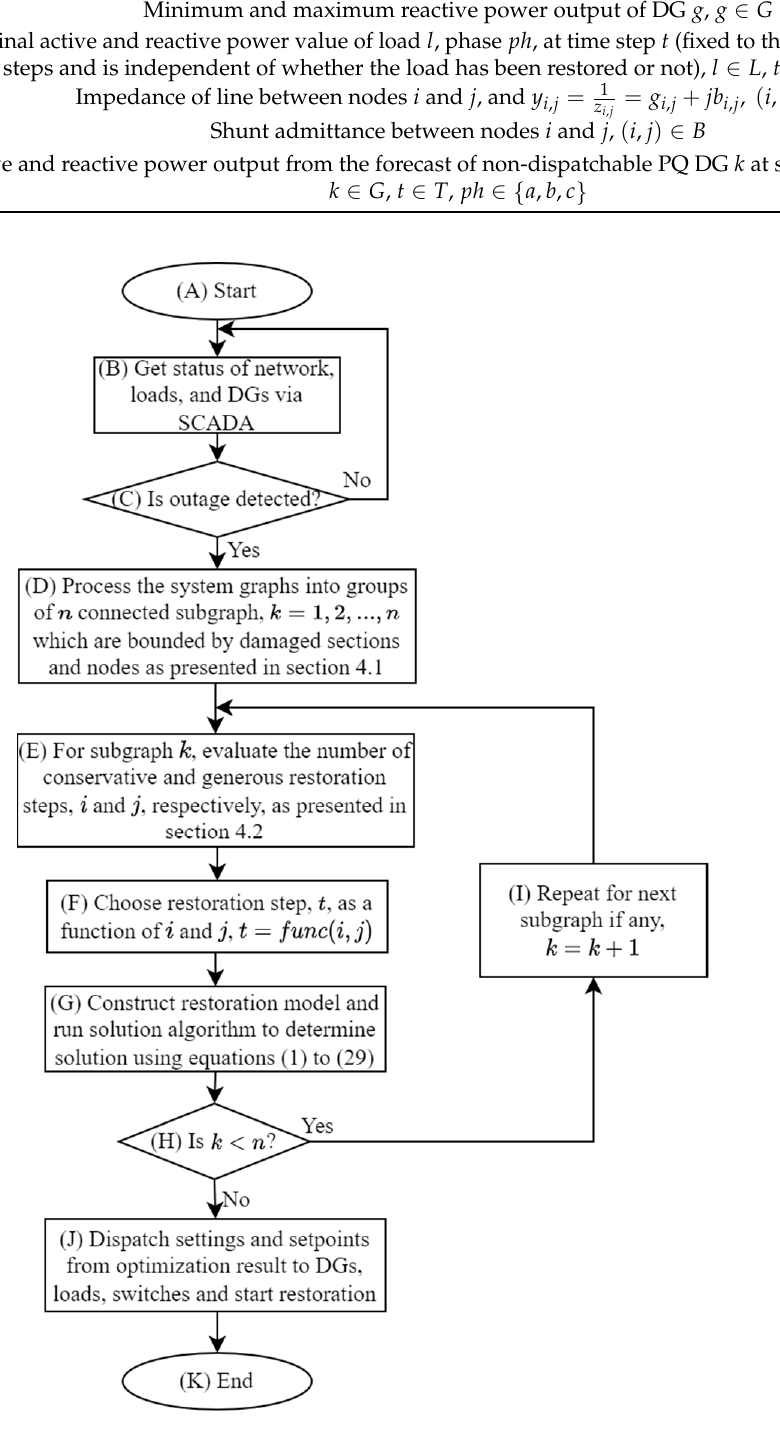
Figure 1. Flowchart of the proposed restoration method.